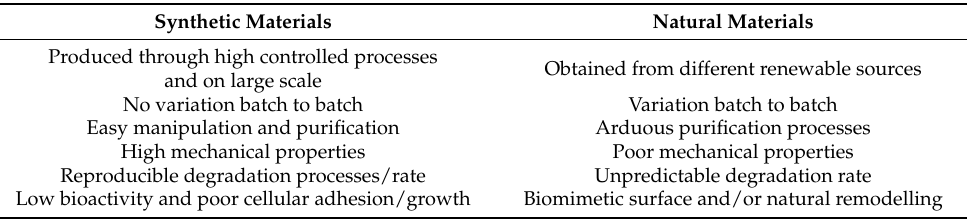
Table 1. Main differences between natural and synthetic materials used in periodontal regeneration.